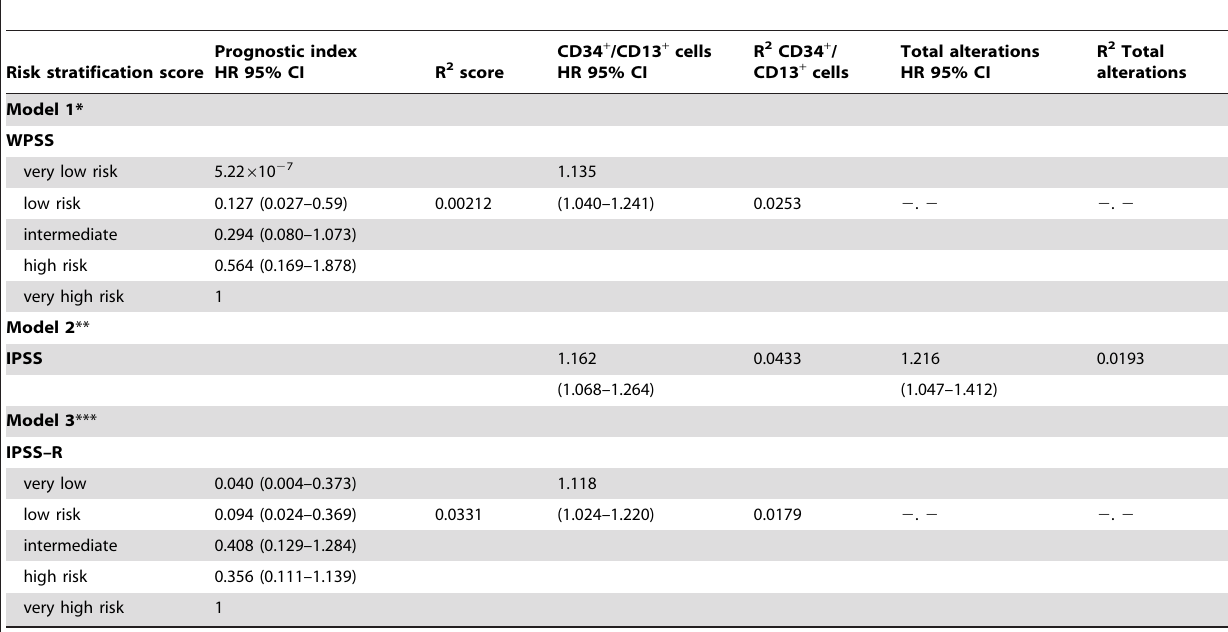
Table 7. Results of the multivariate analysis considering each of the scores analyzed together with the phenotypic variables presenting an impact on overall survival of the patients.